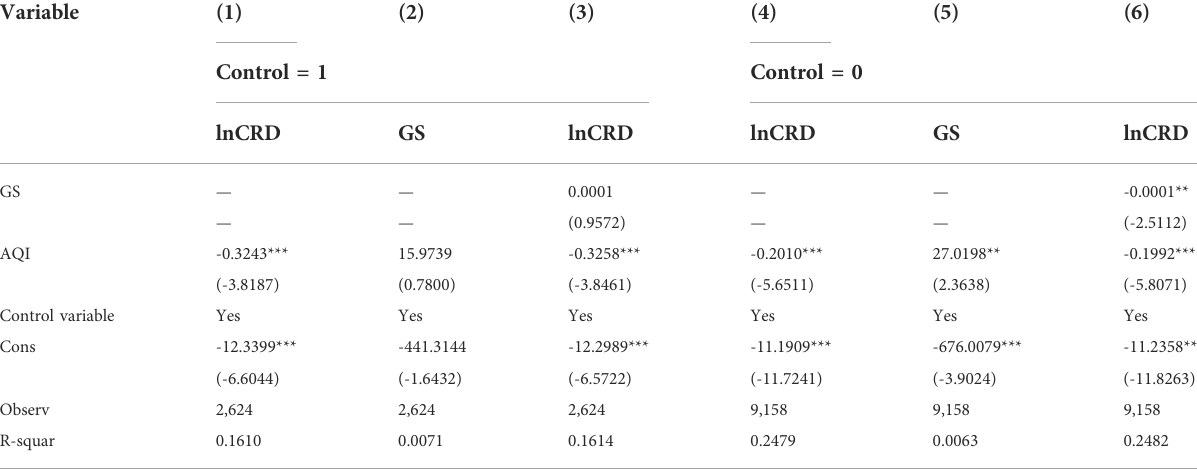
TABLE 13 Heterogeneity analysis of key regulatory enterprises based on government concern.